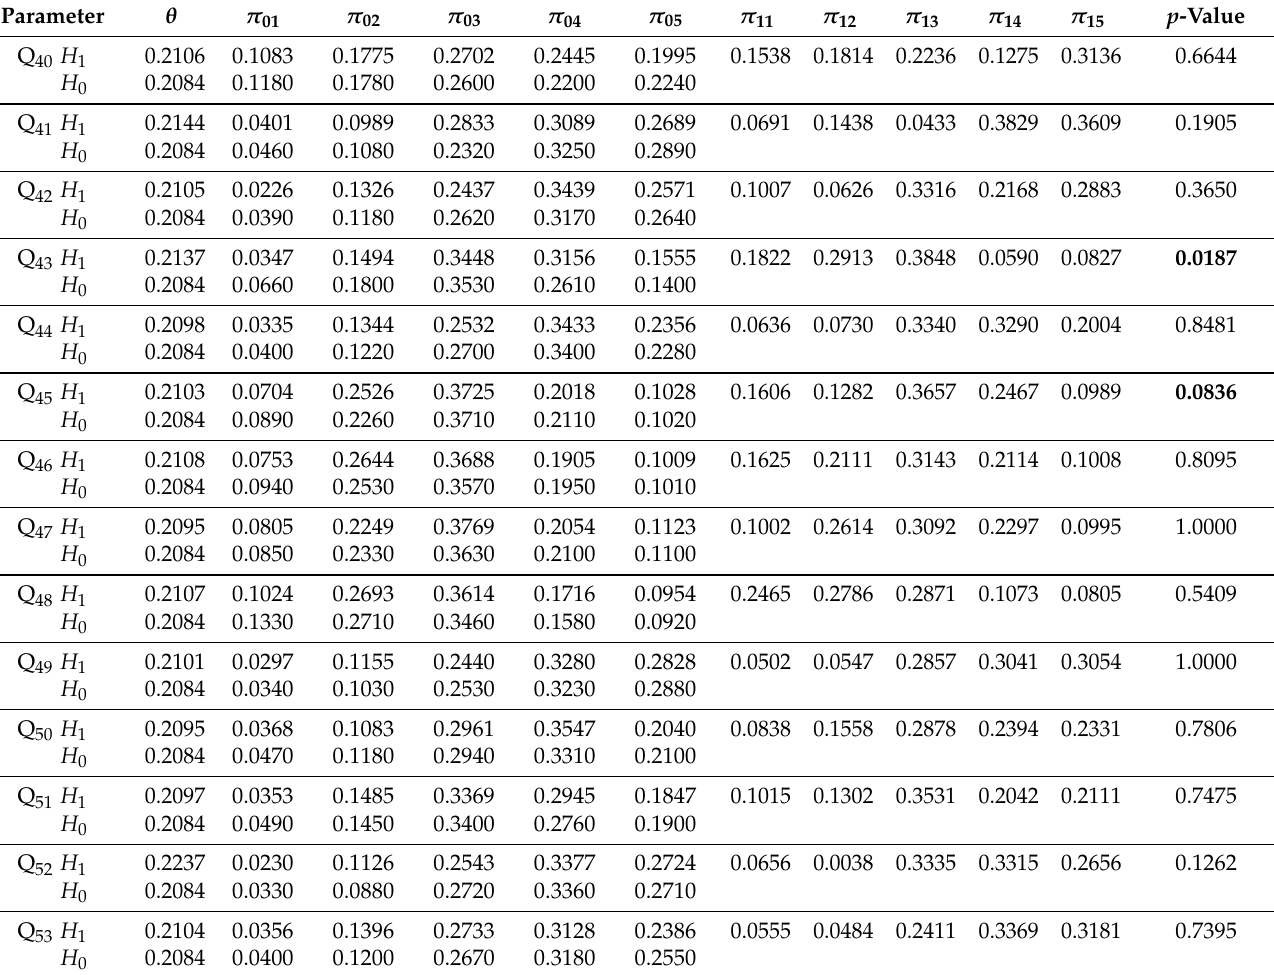
Table 1. Results of the likelihood ratio test and the null and alternative/full models for the association between the sensitive characteristic variable from question 39: “Have you ever had a one-night stand through a dating site or mobile app?”, and each of the 27 observed ordinal categorical random variables for online dating experience corresponding to statements 40 to